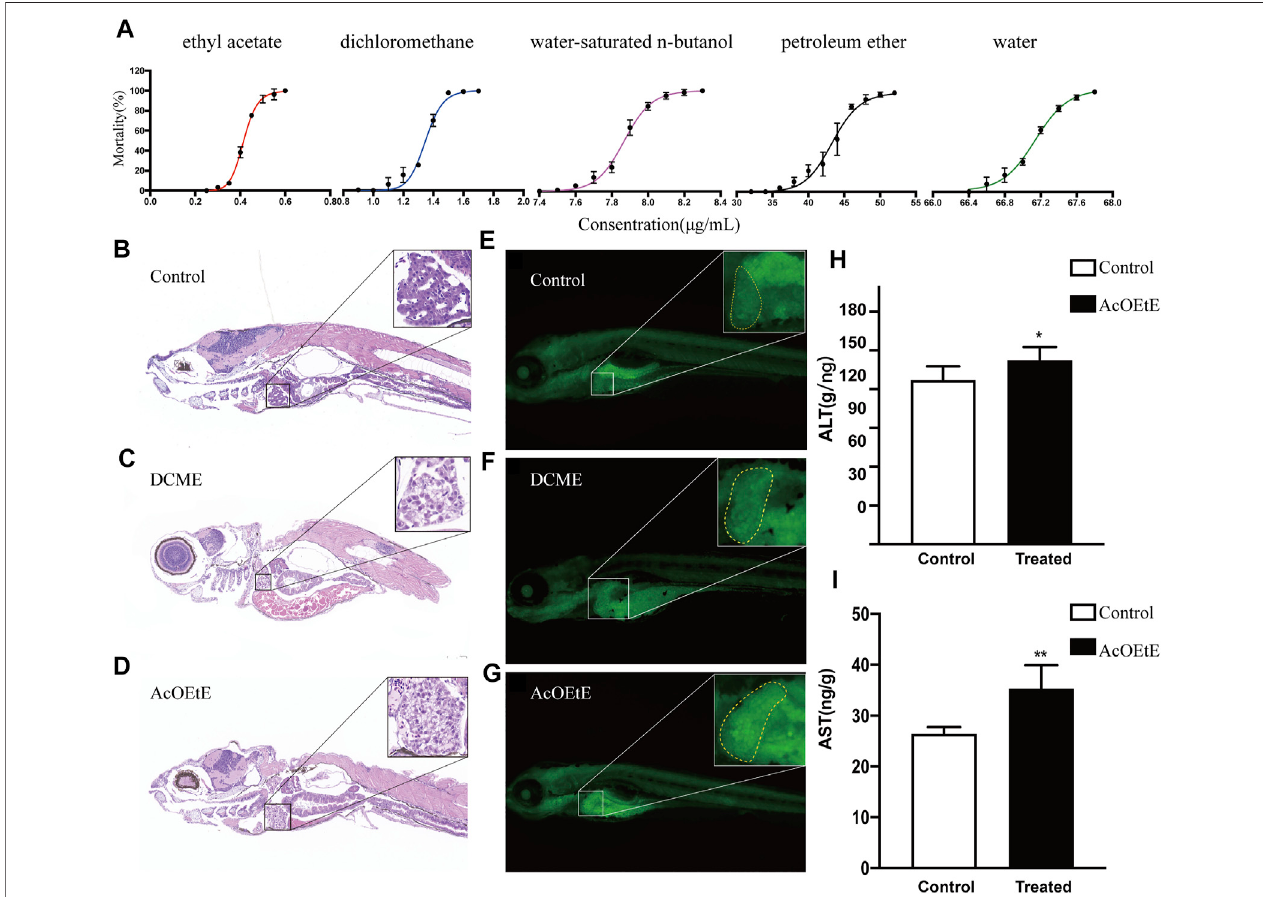
FIGURE1| Concentration-mortalitycurves,tissuesections(×400),andbiochemicalindicatoranalysis (A) Concentration-mortalitycurvesof fi vesolventextractsof Rhizoma Paridis , including petroleum ether extracts (PEE), dichloromethane extracts (DCME), ethyl acetate extracts (AcOEtE), water-saturated n-butanol extracts (WSBE),andwaterextracts(WE) (B-D) H&Estainingofzebra fi shlarvaesectionsfromthecontrol,DCME,andAcOEtEgroups (E – G) Acridineorangestainingofzebra fi sh larvae from the control, DCME, and AcOEtE groups (H – I) The levels of ALT and AST of control and AcOEtE groups. Data are expressed as mean ± SD. ** p < 0.01 compared with the control group, * p < 0.05 compared with control